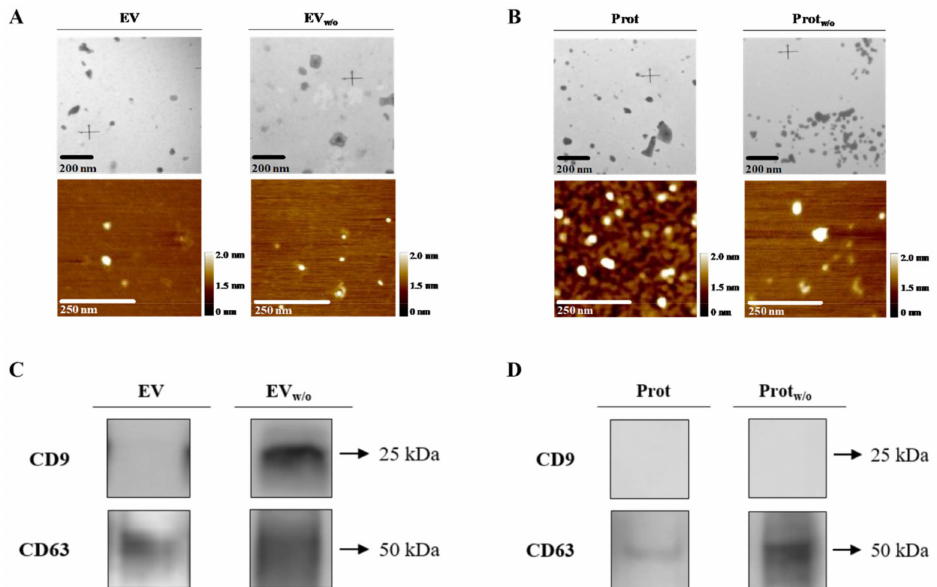
Figure 2. EV, EV w / o , Prot and Prot w / o isolates characterization by TEM, AFM and western blot. ( A , B ) Representative TEM and AFM images for each group of EVs or pooled protein fractions with their respective scale bars. ( C , D ) Typical EV markers (CD9 and CD63) identified by western blot from EV, EV w / o samples or Prot and Prot w / o , loading the same amount of protein for both group